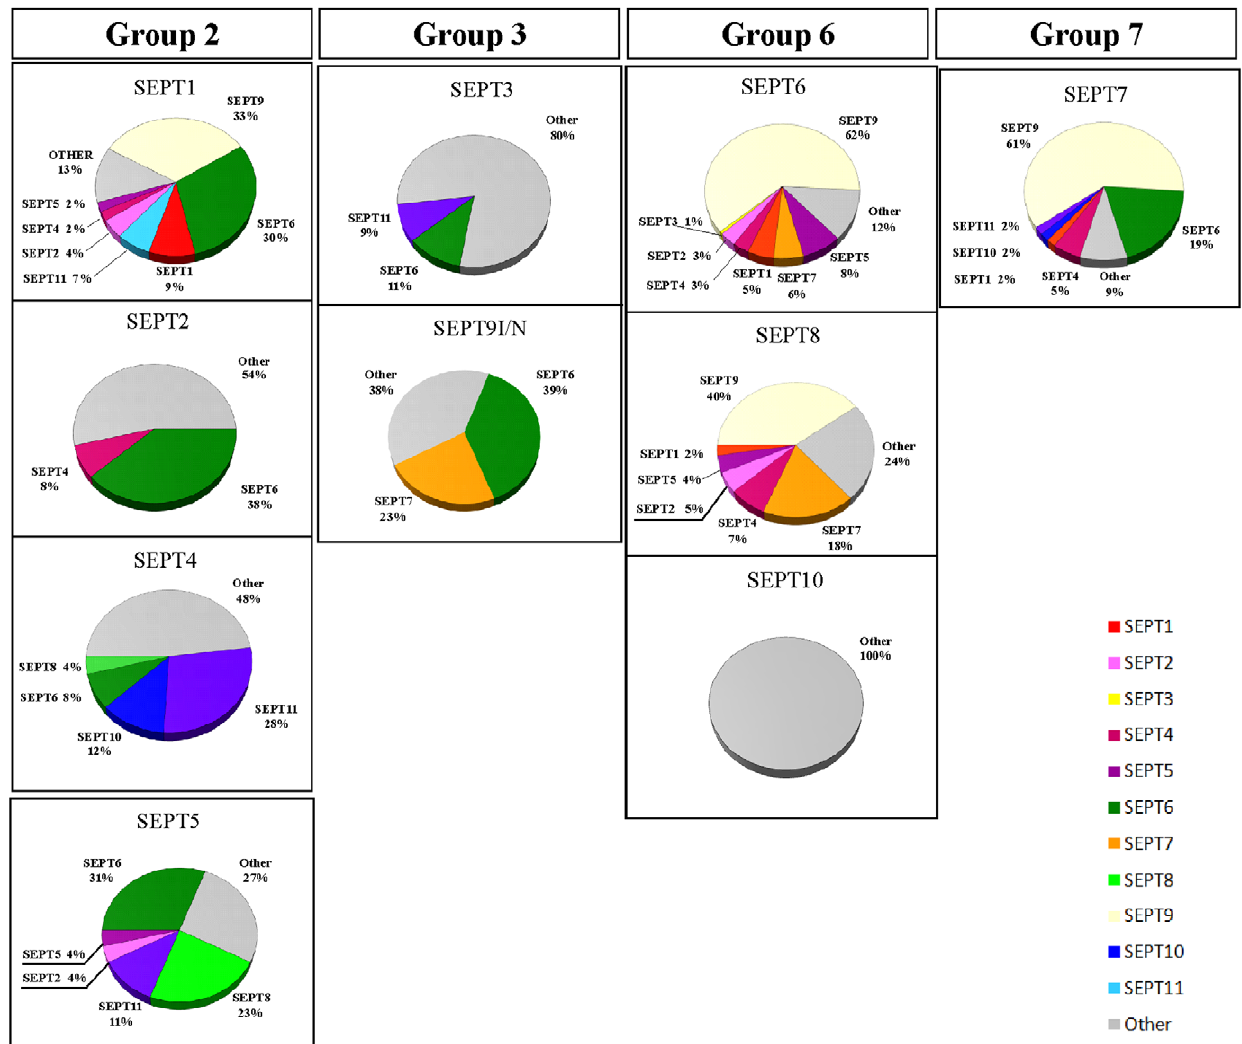
Figure 1. Summary of protein-protein interactions found for human septins 1-10. The values are given as a percentage of clones from the total number of confirmed interacting clones sequenced and identified. See color code for septin specification. Septins are grouped according to the four groups SEPT2, SEPT3, SEPT6 and SEPT7 from left to right.